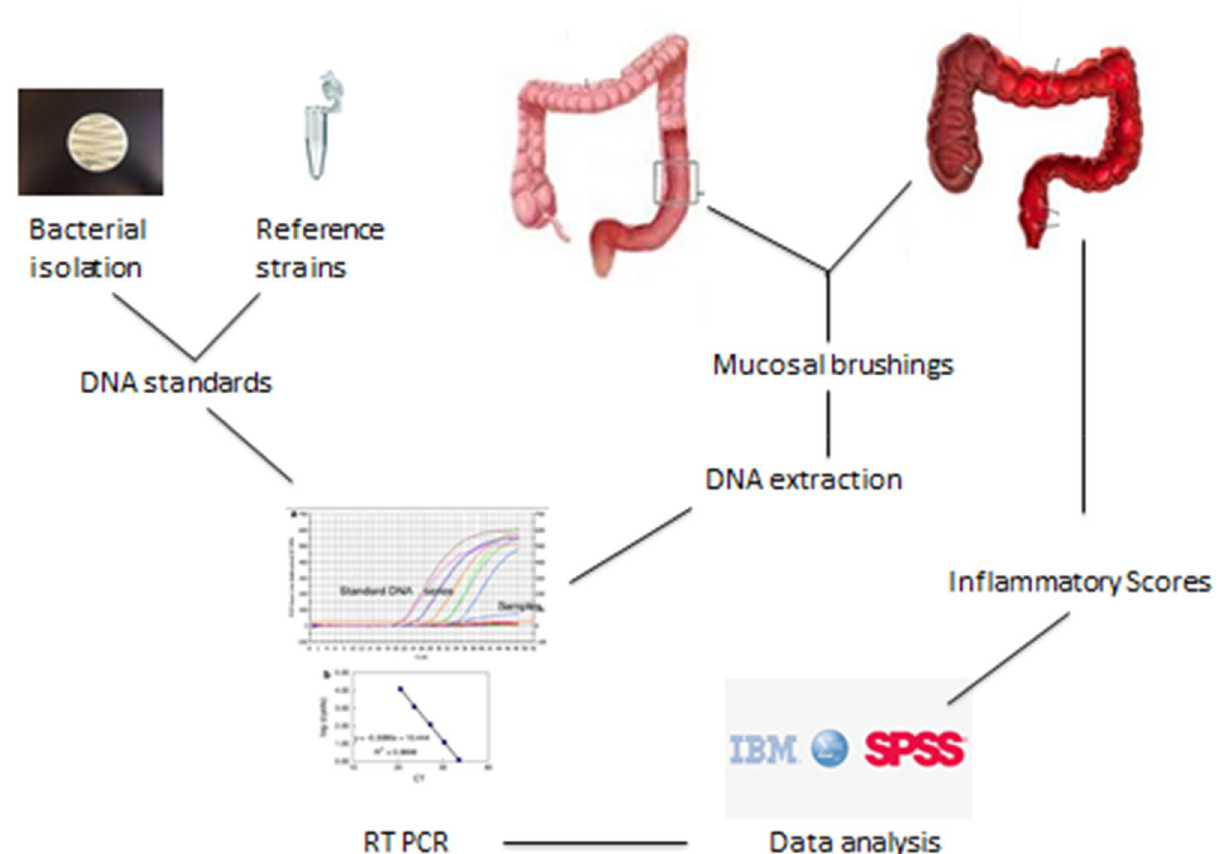
Figure 1. Schematic representing work flow through sample collection to data